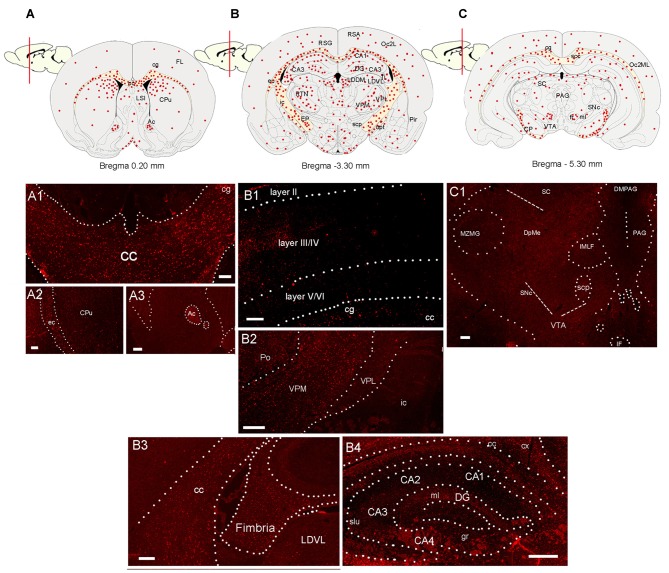
Distribution of CCL5 mRNA positive cells in the rat brain. (A–C) Schematic drawing of three coronal sections of the rat brain indicating where CCL5 mRNA puncta (red dots) were detected. (A1–A3) Representative sections through the corpus callosum (cc) and cingulate cortex (cg), external capsule (ec) and caudate/putamen (CPu), and anterior commissure (Ac). (B1) Representative section through the cerebral cortex denoting CCL5 mRNA punta in different cortical layers (II-IV). (B2) Representative section through the thalamus; ic, internal capsule; Po, posterior thalamic nucleus; VPM, ventroposterior medial nucleus; VPL, ventroposterior lateral nucleus; (B3,B4) representative sections through the hippocampal formation; LDVL, laterodorsal tegmental nucleus; slu, stratum lucidum of the hippocampus; gr, gracile fasciculus; ml, medial lemniscus; cx, parietal cortex; DG, dentate gyrus; (CA1-4), Cornu Ammonis 1-4. (C1) Representative section from the midbrain; scp, superior cerebellar peduncle; SNc, substantia nigra compacta; MZMG, marginal zone of the medial geniculate nucleus; sc, superior colliculus; DpME, deep mesencephalic nucleus; PAG, periaqueductal gray; DMPAG, dorsomedial PAG; IF, interfascicular nucleus; VTA, ventral tegmental area. Scale bar 50 μm for (A1–C1).